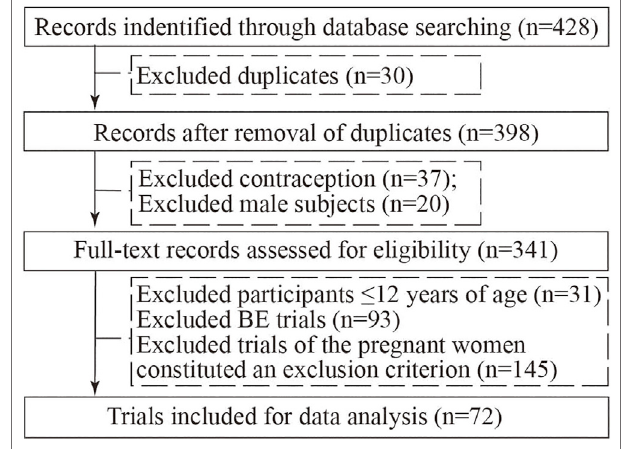
TABLE 2 | Study design of all included